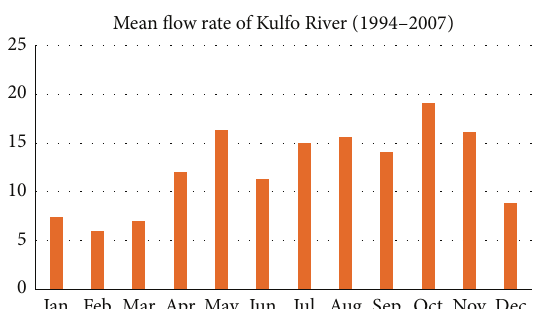
Figure 5: Average stream flow of the Kulfo River